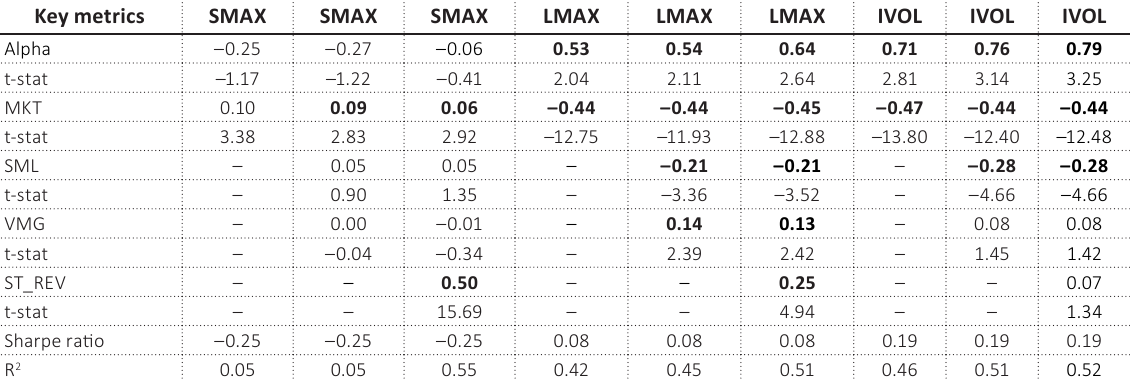
Note: Bold indicates 5% statistical